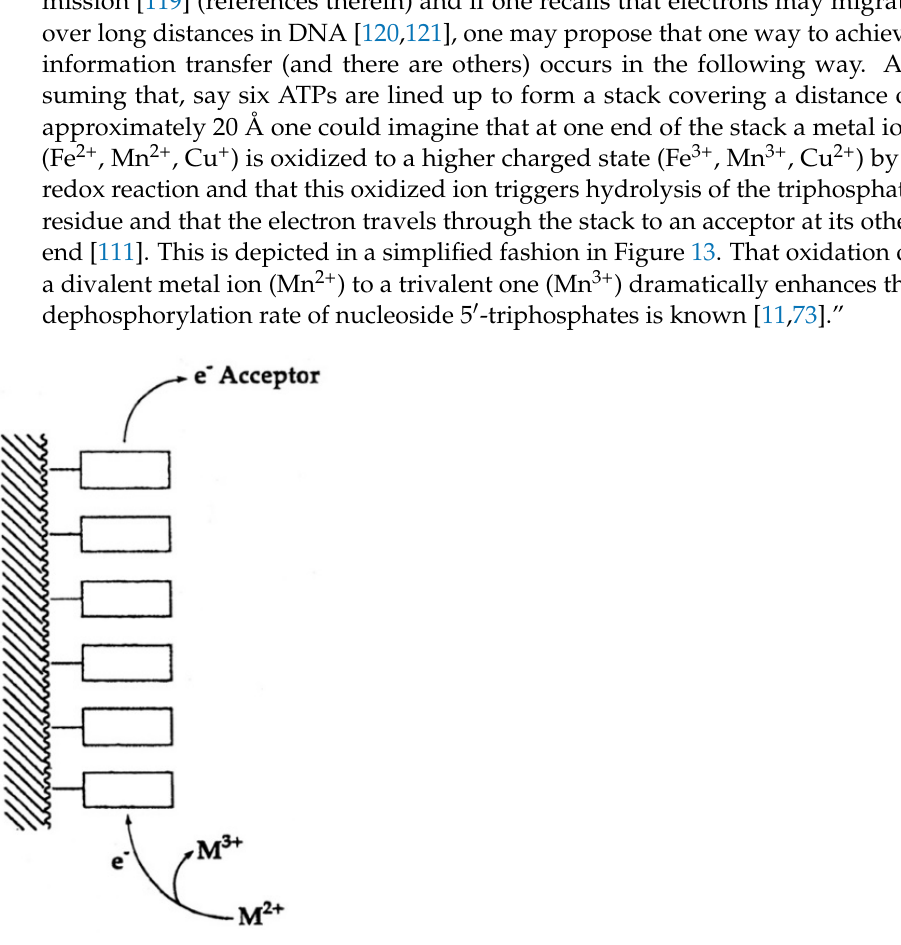
Figure 13. Simplified picture of a matrix-assisted ATP stack indicating an electron and thus an information transfer through this stack from one end to the other. This figure is reproduced with permission from our publication in Pure and Applied Chemistry [21]; copyright 2004, International Union of Pure and Applied Chemistry (IUPAC).